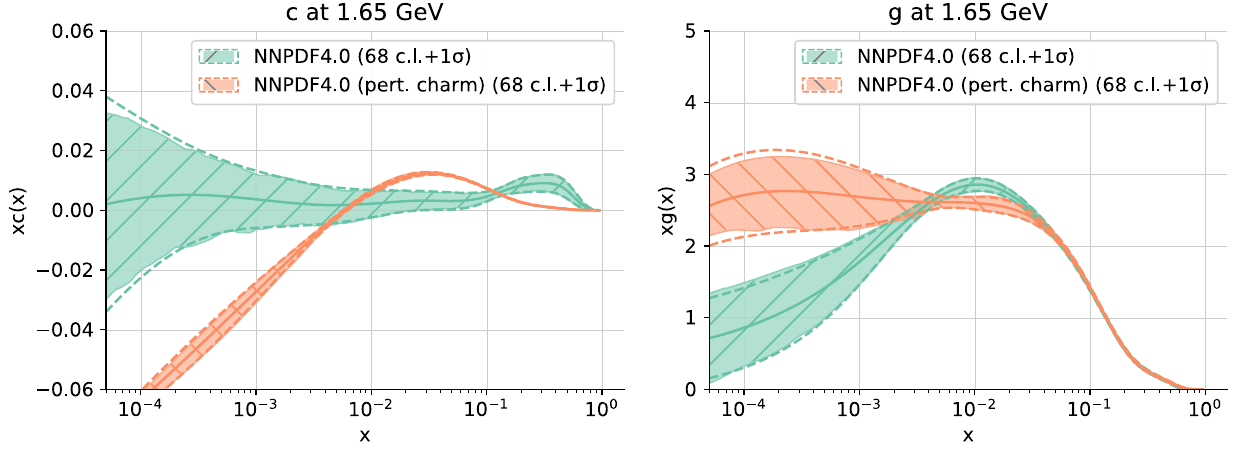
Fig. 52 Same as Fig. 51 for the gluon and the charm PDFs at the parametrization scale Q = 1 . 65 Table 31 The value of the χ 2 per data point for the NNPDF4.0 baseline and its variants with different treatments of nuclear corrections. Values are shown for each process type and for the complete dataset. The value of the φ estimator for the complete dataset is also provided (see text) No nucl. unc. Deut. unc. Deut.